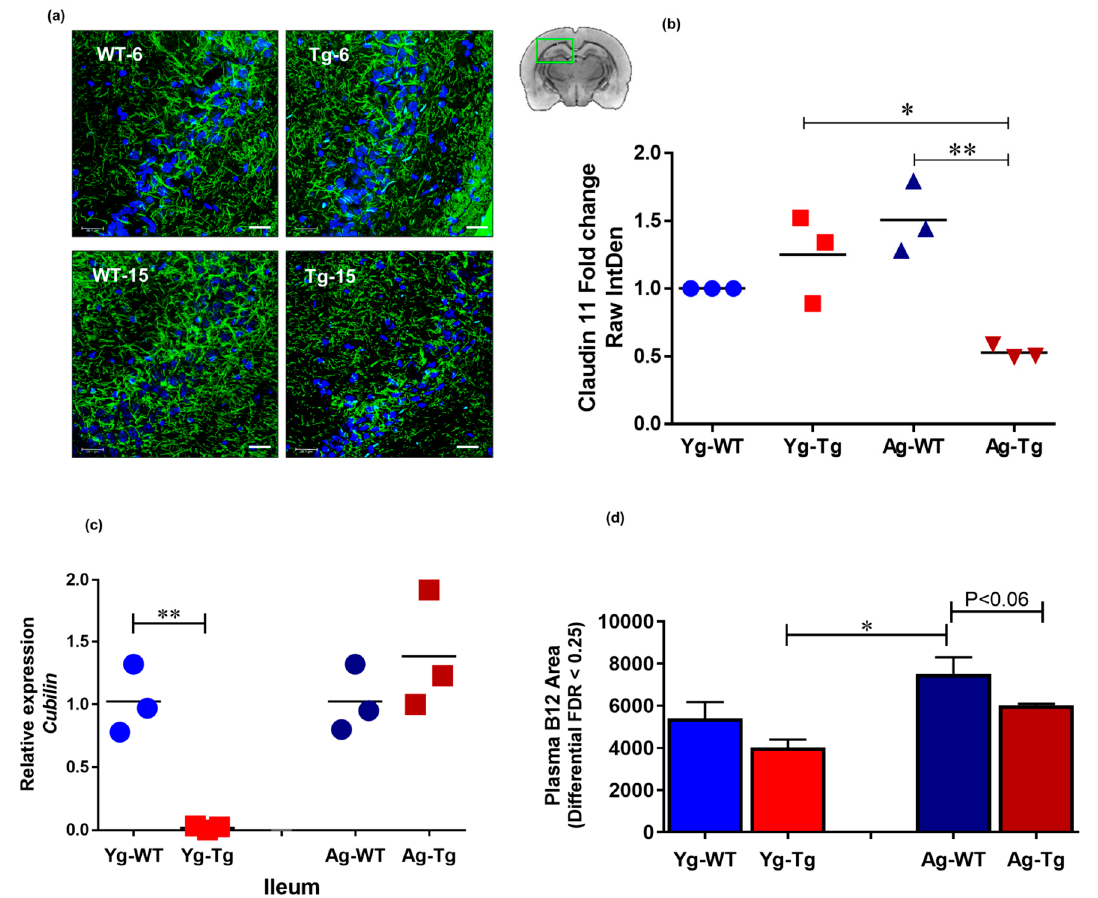
Figure 5. Claudin-11 expression is significantly decreased in symptomatic Tg2576. ( a , b ) immunohistochemical staining of oligodendroglia-specific claudin-11 shows significant loss of claudin-11 expression in Tg2576 mice at 15 months (Ag-Tg), but not at 6 months (Yg-Tg).( c ) Transcriptomic analysis using Taqman probes targeting cubilin in the ileum of Tg2576 and WT littermate controls shows nearly undetectable Cubilin gene expression in the ileum of Tg2576 mice at 6 months (Yg-Tg) compared to the WT littermate controls